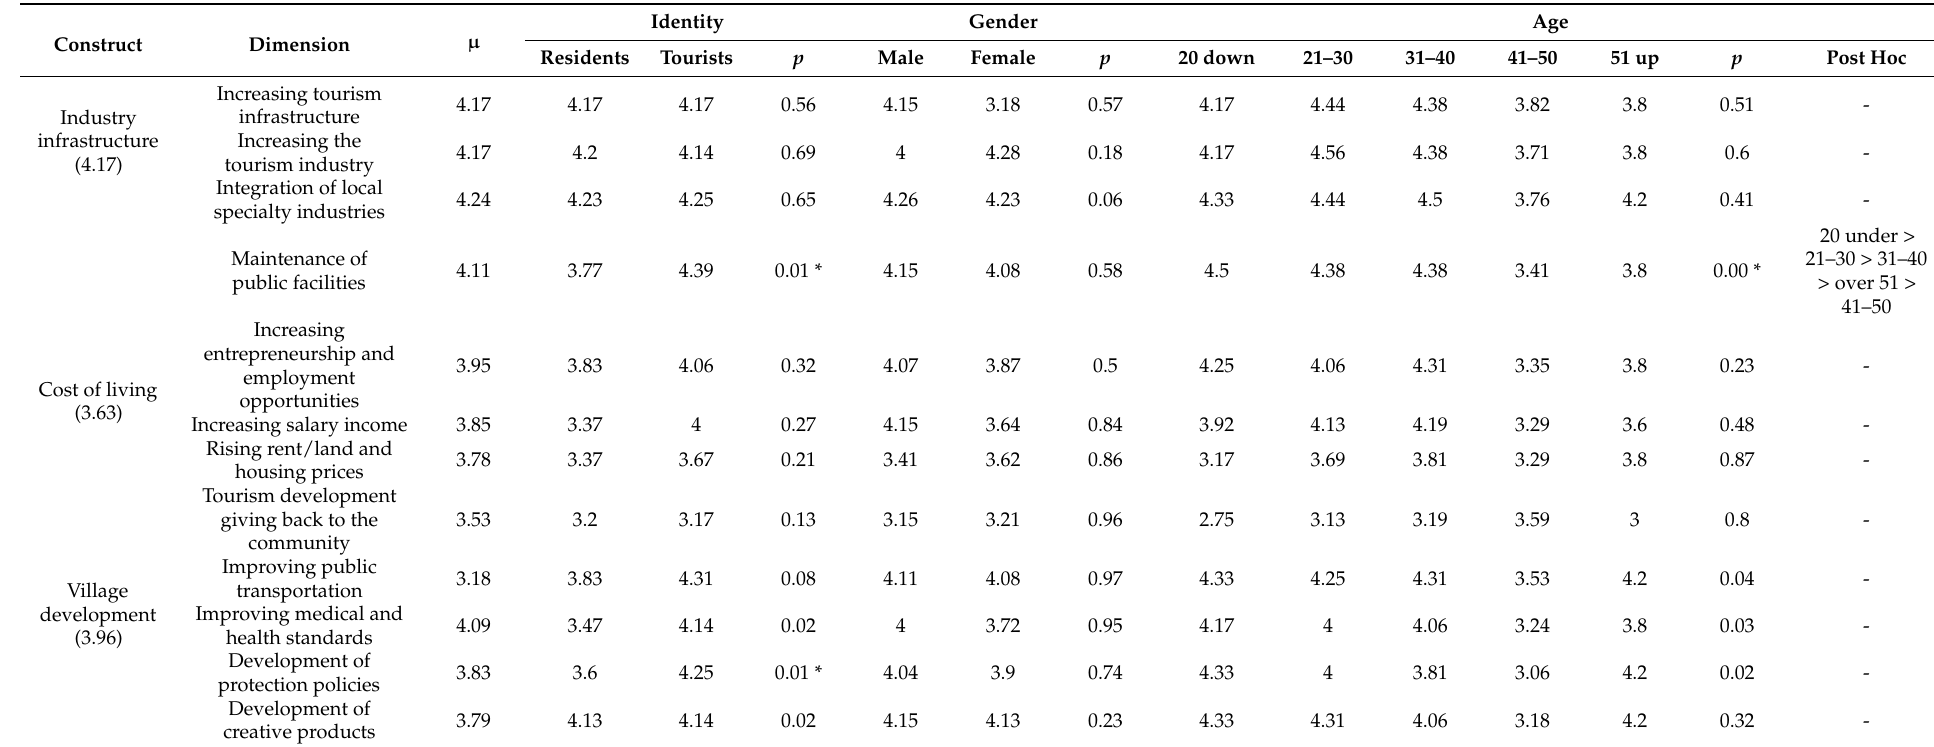
Table 4. Analysis of the awareness of the impact of religious and cultural tourism on the village